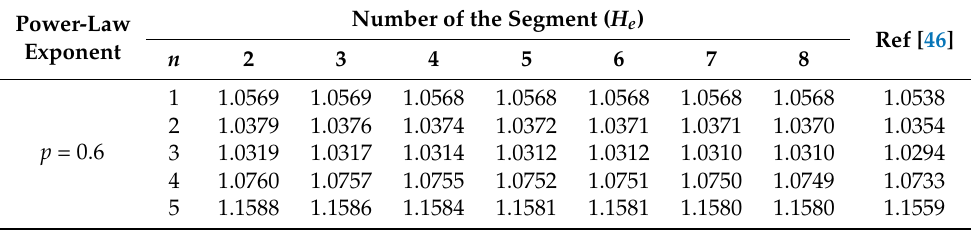
Table 2. Frequency parameter Ω of the FGM I ( a = 1; b = 0; c ; p ) spherical shell structure (BC; C–C, m =